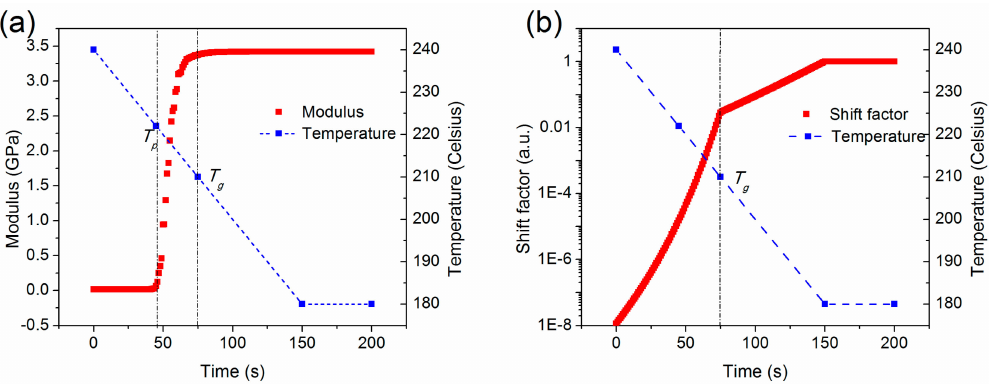
Figure 6. Mechanical property changes during cooling process. ( a ) Young’s modulus; and ( b ) shift